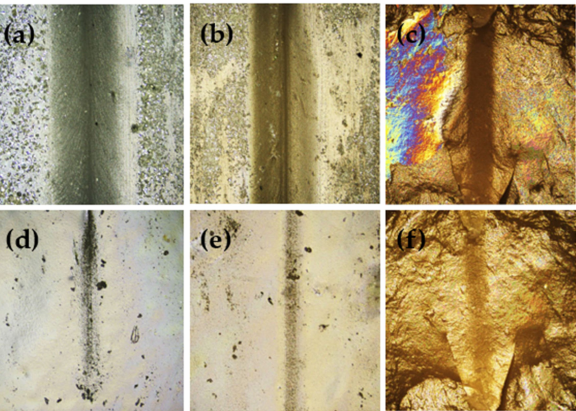
Figure 8. The optical micrographs of the EPDM- g -MAH/HA60D and EPDM /HA60D mixtures taken before ( a – c ) and after ( d – f ) thermal exposure for 24 h: ( a ) 60/40 EPDM- g -MAH/HA60D, ( b ) 70/30